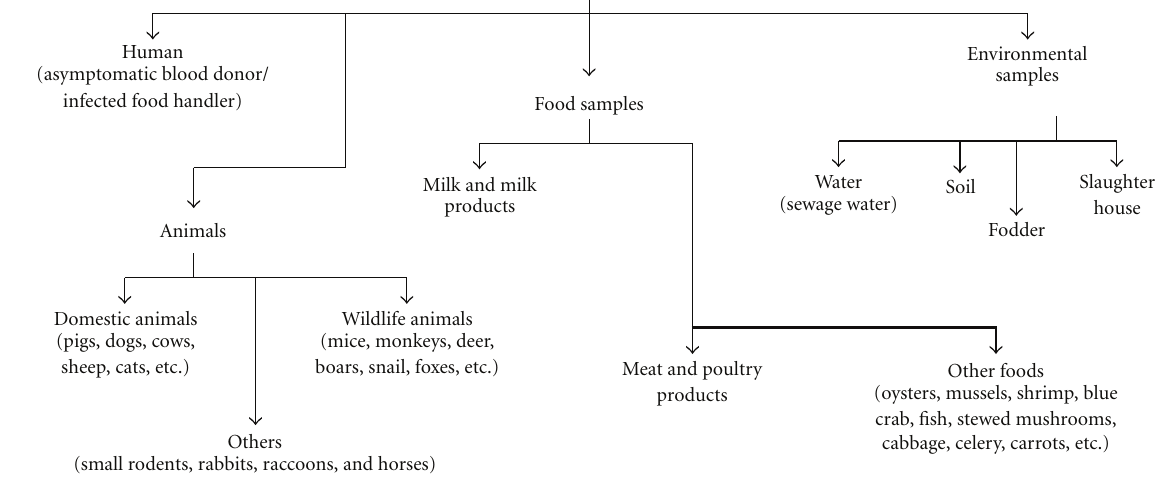
Figure 1: Occurrence of Y. enterocolitica in natural